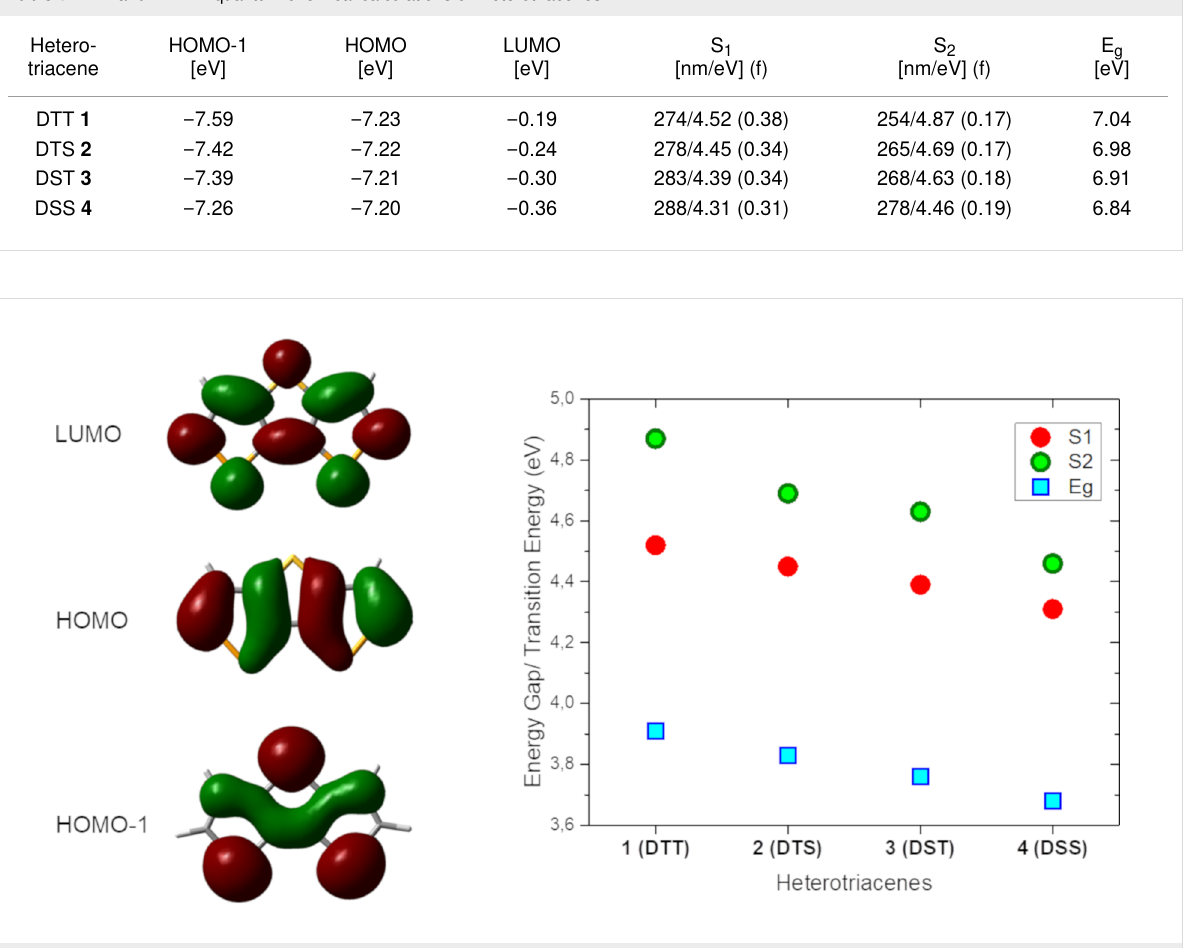
Figure 5: Representative electron density of frontier orbitals LUMO, HOMO, and HOMO-1 for heterotriacene DSS 4 (left). Energy of the first S 1 (red dot) and second S 2 (green dot) electronic transition calculated with TD-DFT and experimental energy gap (blue squares) of heterotriacenes 1 to 4